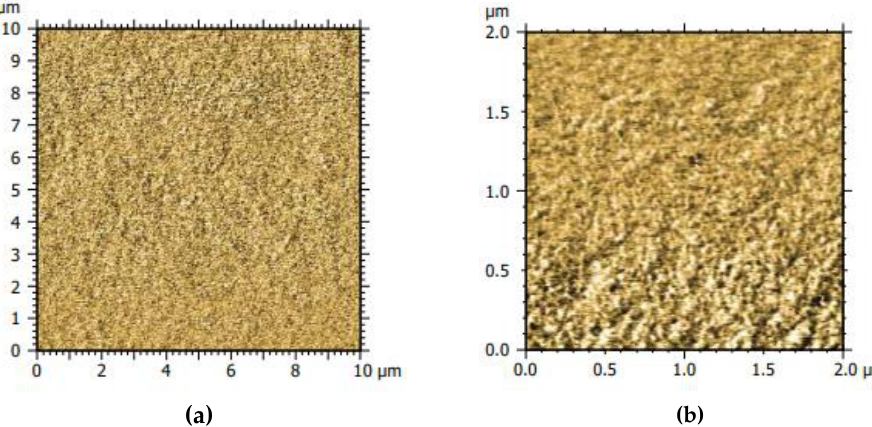
Figure 4. The AFM phase identification pictures of the ProMa coating surface on silica wafer ( a ) section 10 µm × 10 µm, (b ) section 2 µm × 2 µm.